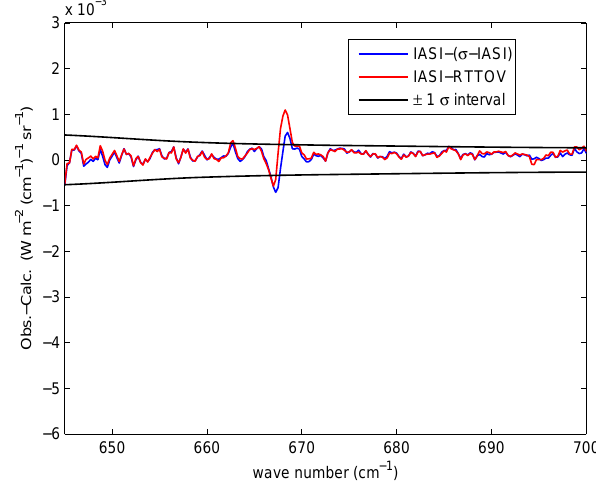
Fig. 12. Same as Fig. 7, but now the input state vectors have been obtained by direct inversion of IASI